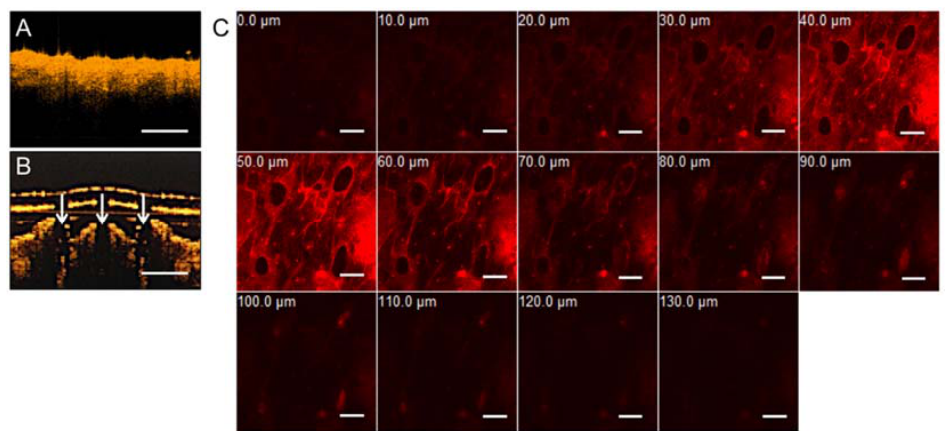
Figure 3. In vitro transdermal delivery of R6G in mice via patches of gelatin/CMC MNs. ( A ) OCT image of mice skin before MNs insertion. ( B ) OCT image of mice skin after insertion. White arrows indicate the location of micro-disruption in the dermis. Scale bar = 500 μ m. ( C ) The R6G-loaded gelatin/CMC MNs penetrate mice skin at certain depths after insertion for 60 min. Scale bar = 200 μ m.